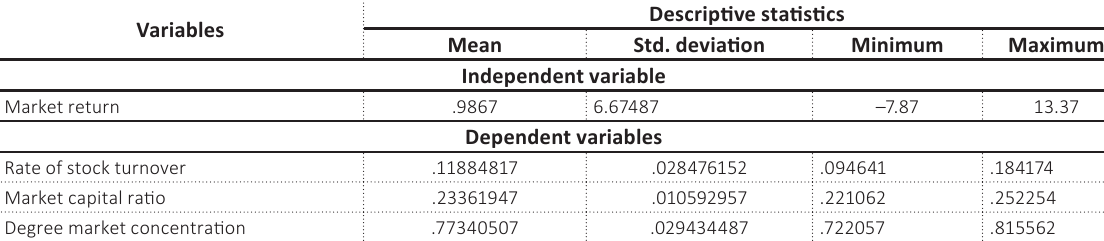
Table 3. Descriptive statistics